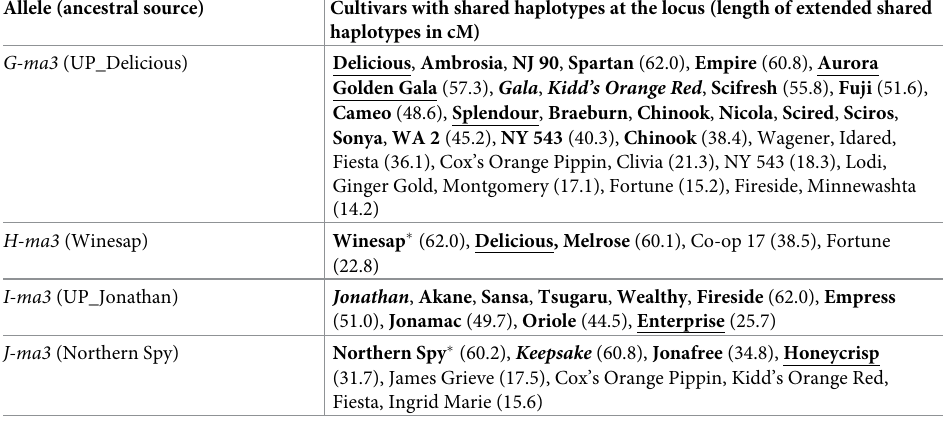
Individuals in bold shared the haplotypes via IBD, while the rest shared haplotypes via IBS. Underlined individuals are the nine important breeding parents of [40]. Italicized individuals are ancestors of the important breeding parents for which allele assignment was also determined in [40]. Individuals annotated with an asterisk ( � ) are ancestral sources of alleles. Immediately flanking haplotypes of the trait loci were identical for the following sets of alleles: B , B , and G-Ma ; H-ma and I-ma ; C and C Ws -Ma F2 -Ma3 ES -Ma3 J -Ma